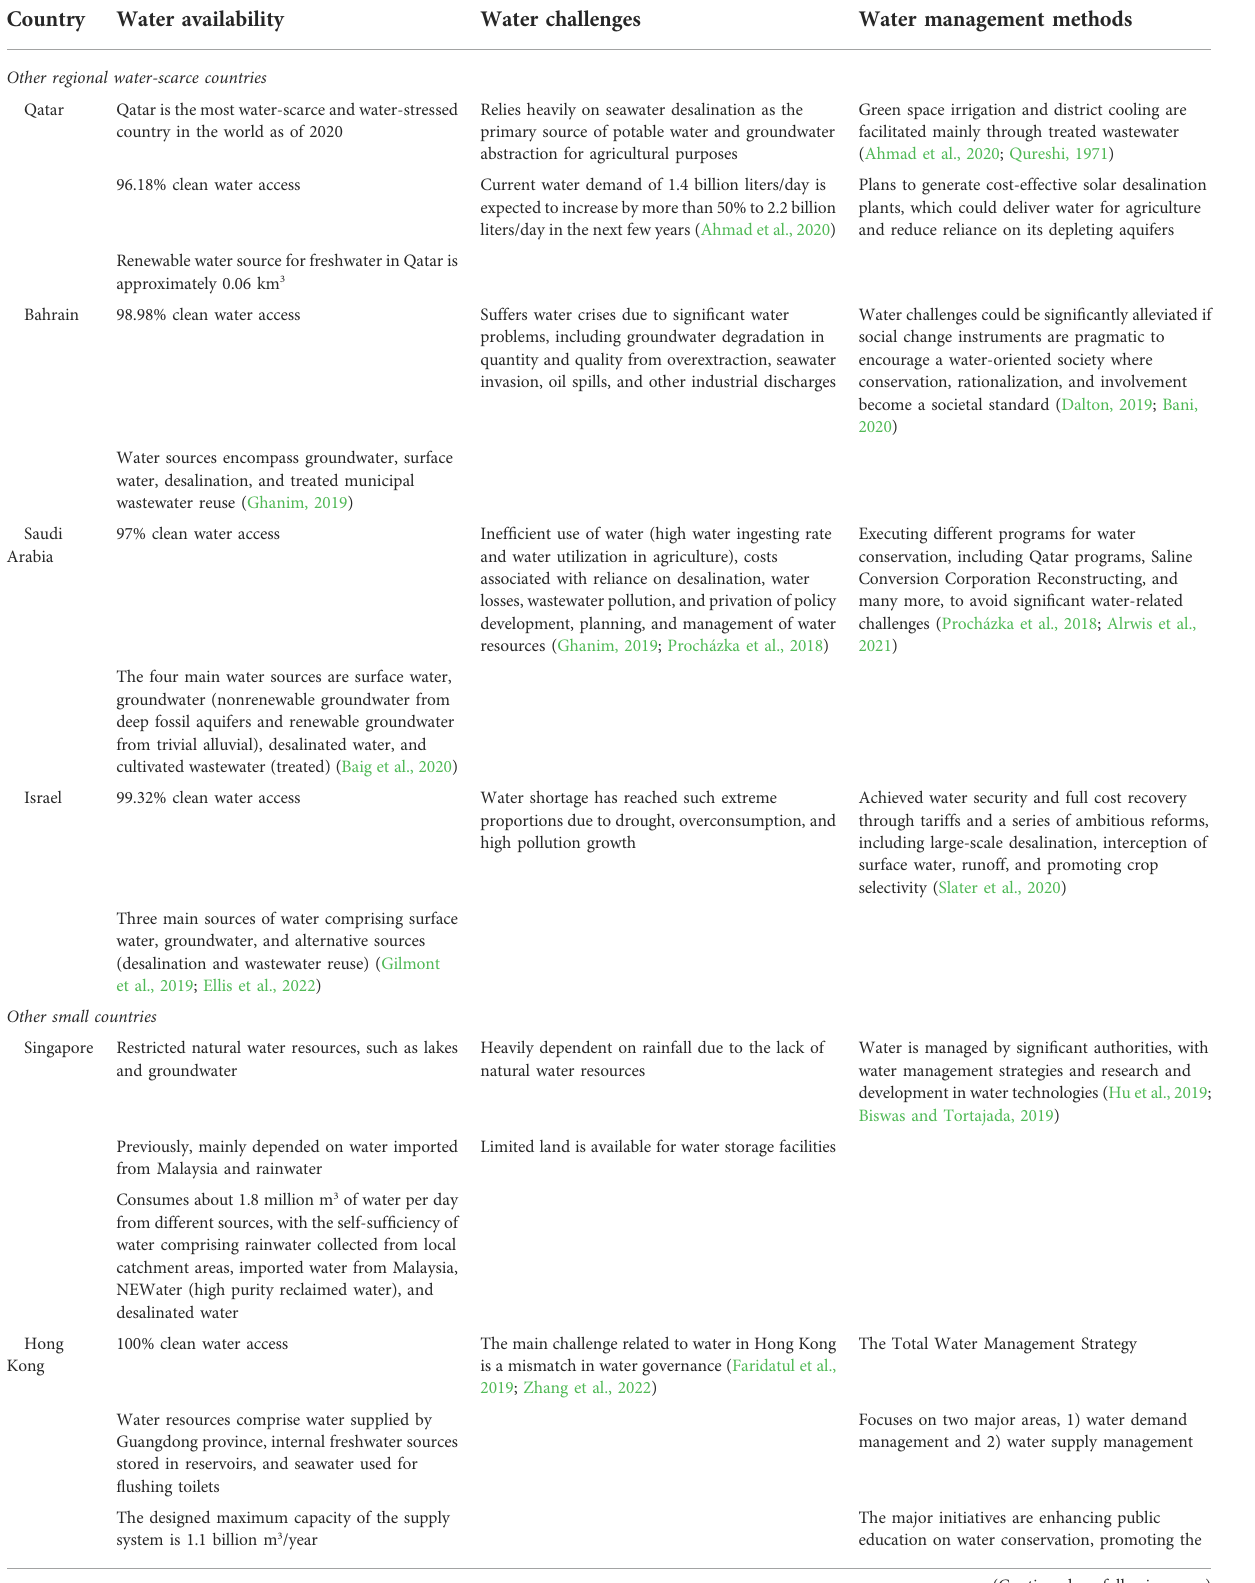
TABLE 7 Comparison of water management in countries with similar